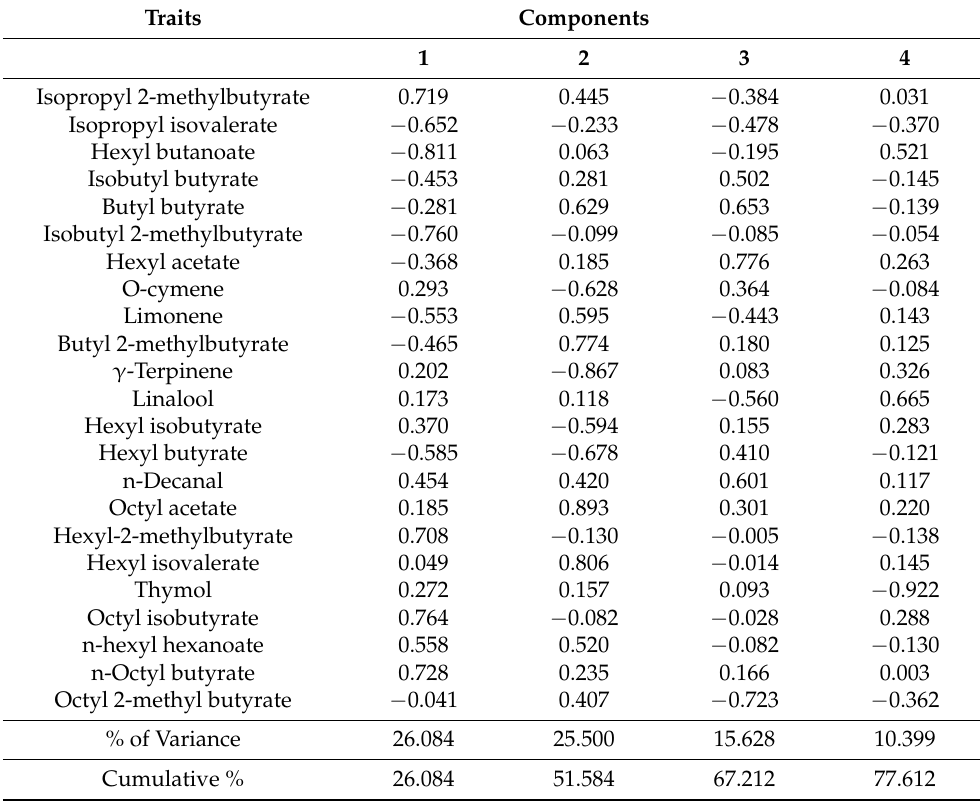
Table 2. Eigenvectors of the first four principal component axes from PCA analysis of variables in studied H. persicum